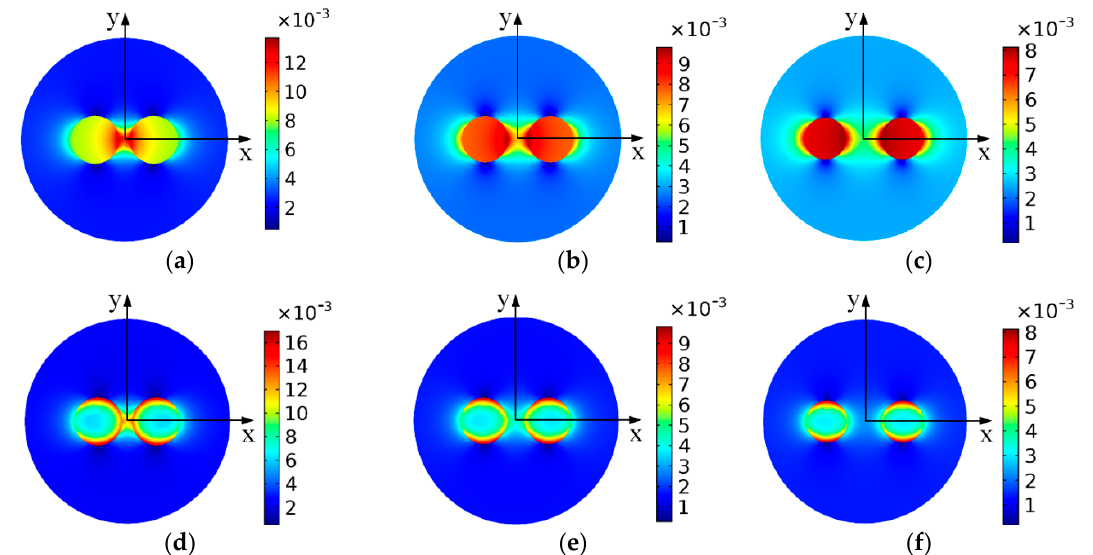
Figure 8. The flux density distribution of the dual wear particles system ( a ) f e = 0 Hz, l p = 0.4 r a ; ( b ) f e = 0 Hz, l p = 0.8 r a ; ( c ) f e = 0 Hz, l p = 1.6 r a ; ( d ) f e = 100 kHz, l p = 0.4 r a ; ( e ) f e = 100 kHz, l p = 0.8 r a ; ( f ) f e = 100 kHz, l p = 1.6 r a .